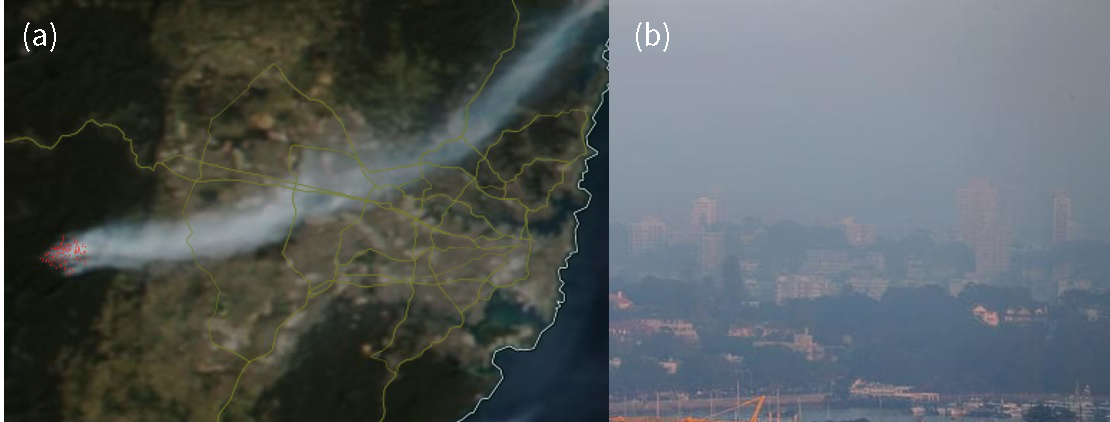
Figure 3. ( a ) MODIS image and thermal anomalies over Sydney on 14 August 2017 (Source: https: //worldview.earthdata.nasa.gov) and ( b ) picture of smoke in Sydney from a news article citing the hazard reduction burns as the cause (Photo by John Grainger reproduced with kind permission from photographer. Source: News Corp